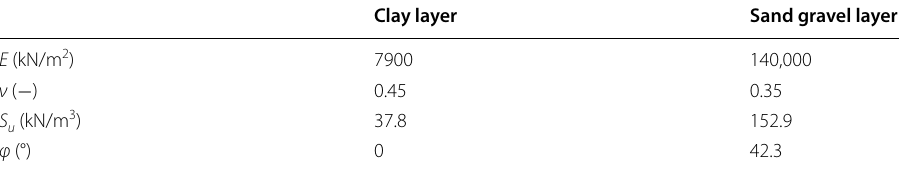
Table 2 Ground parameters Clay layer Sand gravel layer